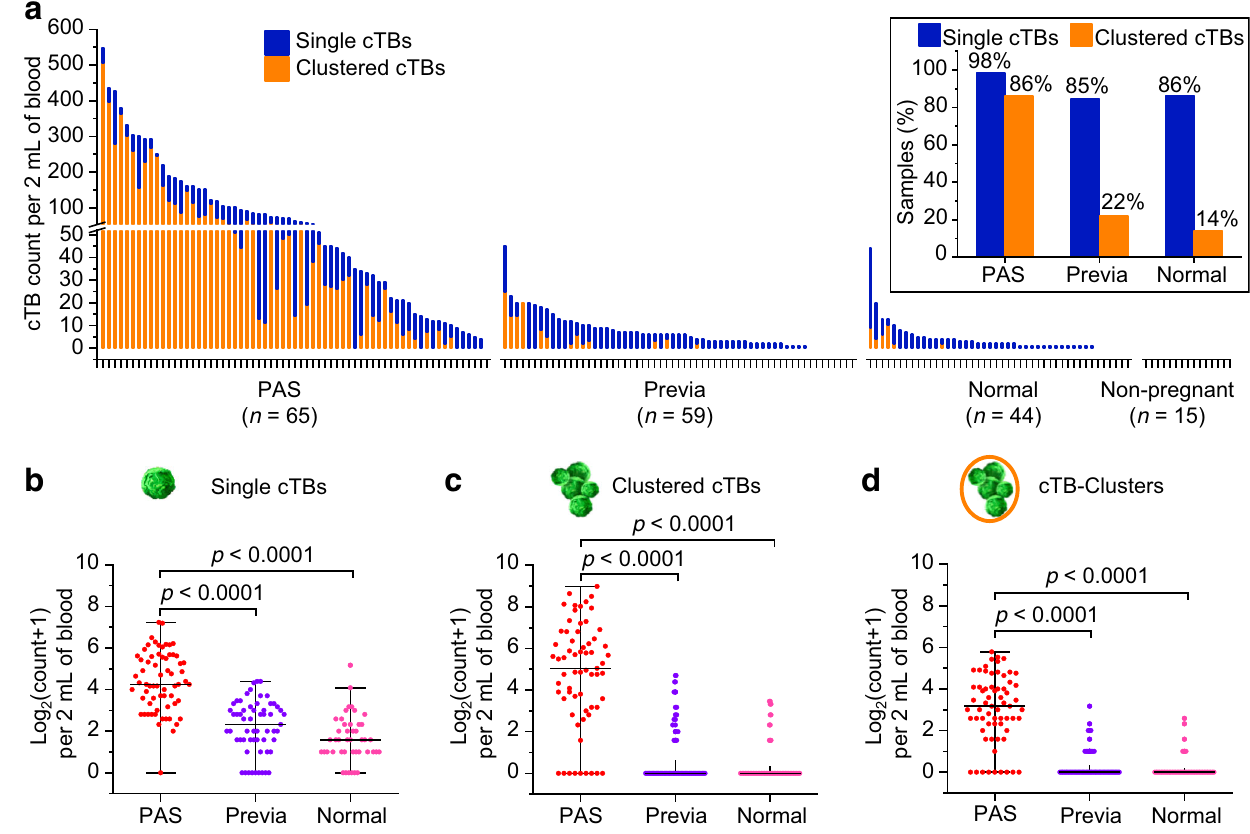
Fig. 5 Comparison of single and clustered cTBs, as well as cTB-clusters in PAS, placenta previa, and normal placentation. a Counts of single and clustered cTBs per 2 mL of blood for all participants enrolled in the study ( n = 183). Pregnant women ( n = 168) are divided into three groups (i.e., PAS, placenta previa, and normal placentation) based on clinical diagnosis and sorted within groups based on total cTB count (single cTB count plus clustered cTB count). Non-pregnant indicates the control cohort of healthy non-pregnant female donors ( n = 15). The inset shows the percentages of pregnant women with detectable single and clustered cTBs in PAS, placenta previa, and normal placentation. Counts of: b single cTBs, c clustered cTBs, and d cTB- clusters per 2 mL of blood for pregnant women with PAS ( n = 65), placenta previa ( n = 59), and normal placentation ( n = 44) are shown. Counts are log2- transformed. The two shorter horizontal lines denote the 25 – 75% interquartile ranges (IQR) and the longer horizontal lines in between denote the median. Data are expressed as mean ± SE for b single cTBs: PAS (4.4 ± 0.2), placenta previa (2.2 ± 0.2), normal placentation (1.6 ± 0.2); c clustered cTBs: PAS